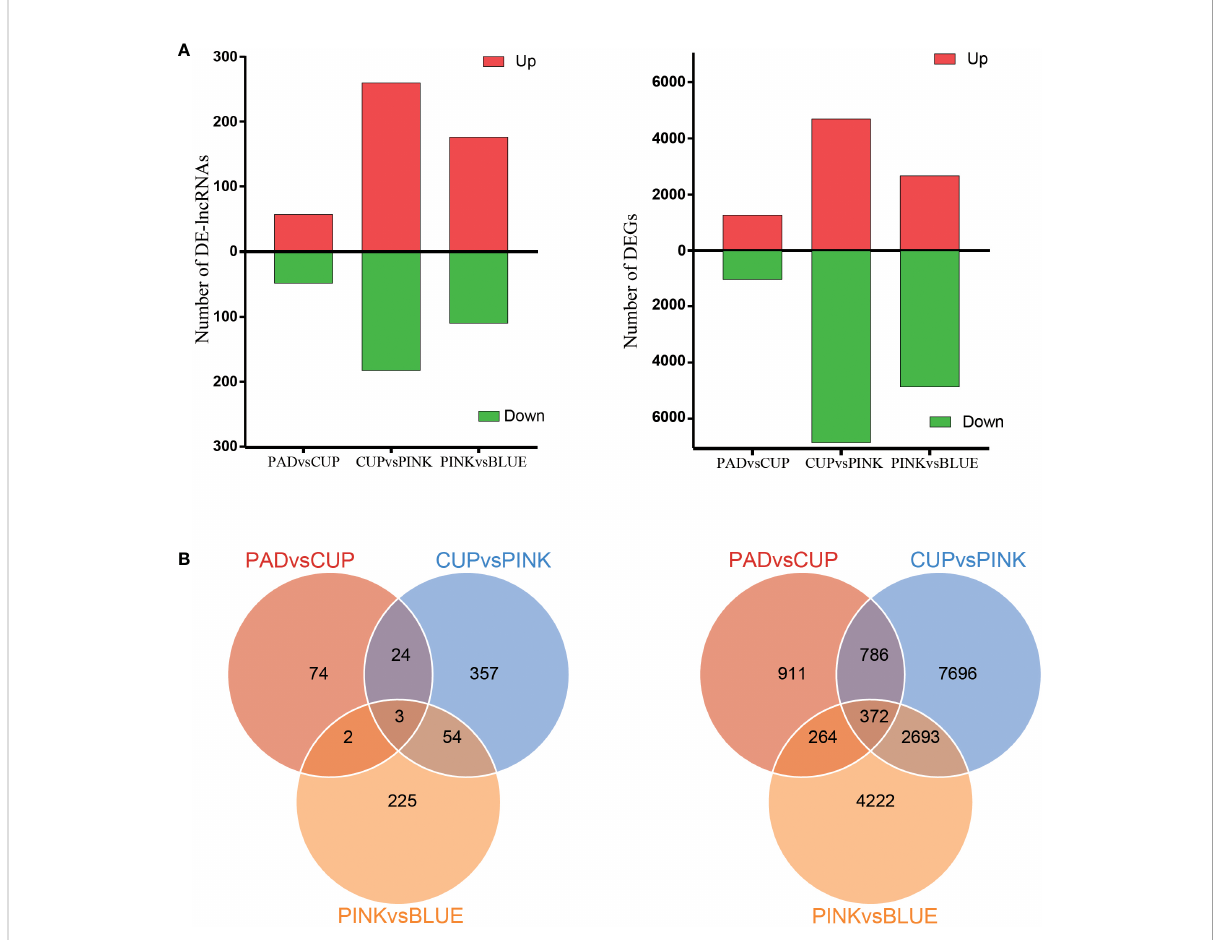
FIGURE 3 Analysis of differentially expressed lncRNAs and mRNAs. (A) Numbers of upregulated and downregulated lncRNAs (left) and mRNAs (right). (B) Venn diagrams of the numbers of differentially expressed lncRNAs (left) and mRNAs (right) between three